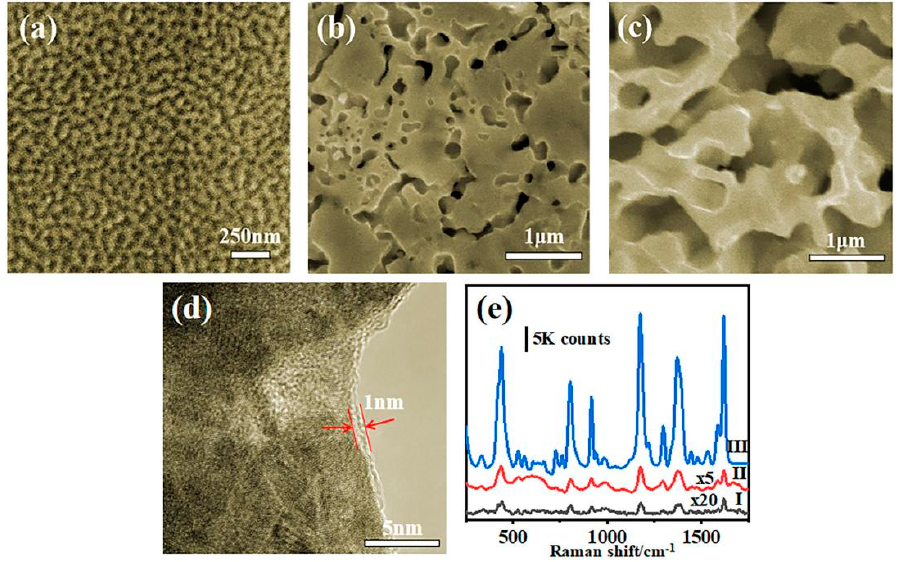
Figure 2. SEM images of NPG prepared with etching precursor alloy ( a ) annealed at 200°Cwithout carbon covering, ( b ) annealed at 300°C without carbon covering and ( c ) annealed at 300°C with carbon covering; ( d ) TEM of C@NPG (annealed at 300°C with carbon covering), carbon layer is high ‐ lighted by red dashed line; ( e ) Raman spectra of 10 − 6 M crystal violet (CV) molecules adsorbed on NPG prepared at different situations (precursor annealed at 200°C without carbon covering, line Ⅰ ; precursor annealed at 300°C without carbon covering, line Ⅱ ; precursor annealed at 300 °C with carbon covering, line Ⅲ ). Note: “×5” and ”×20” indicate the intensities are magnified by 5 and 20 times for comparison.